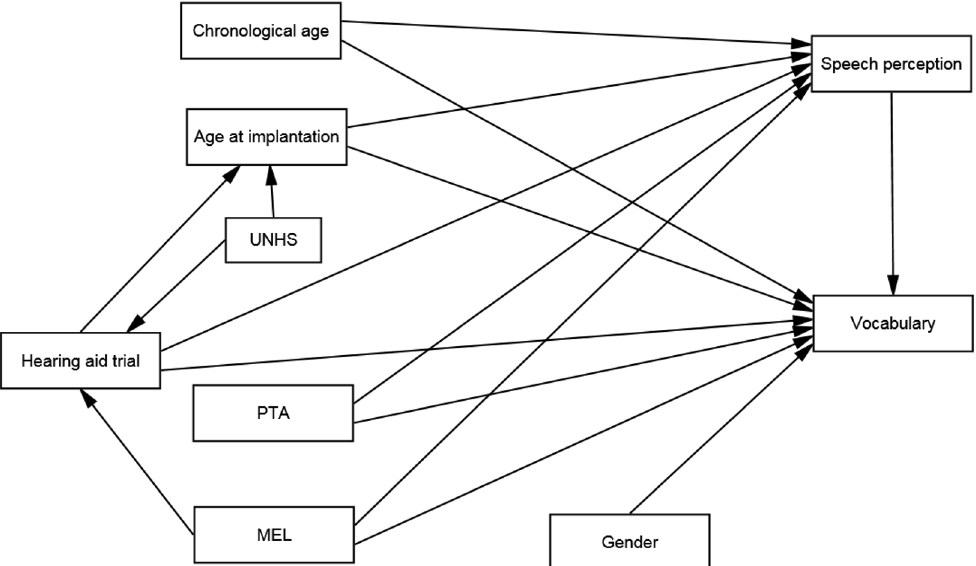
Fig 1. The a priori model tested in the current study. This is a path diagram describing the hypothesized effects of demographical factors on speech perception and vocabulary skills. Unidirectional straight arrows indicate the predicted direction of the hypothesized effect. Note: UNHS: universal